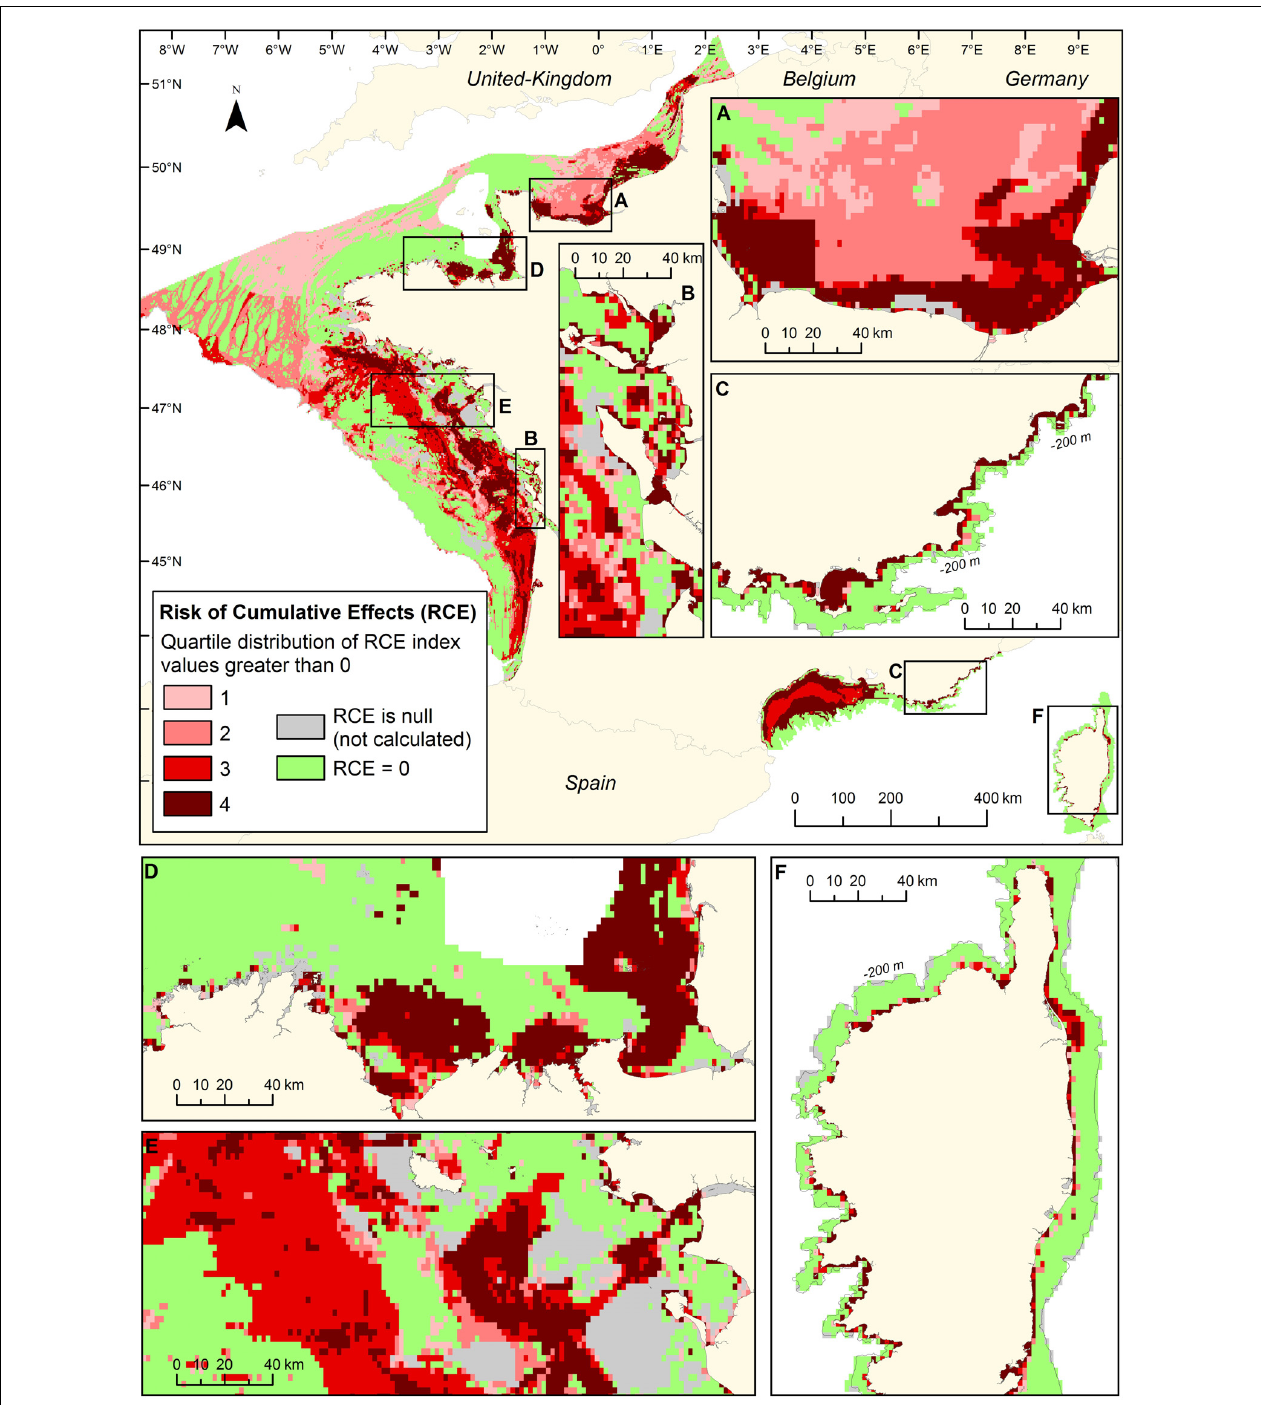
FIGURE 5 | Risk of Cumulative Effects map. (A) Bay of Seine, (B) Pertuis Charentais and Gironde estuary, (C) French Riviera (Côte d’Azur), (D) Normand-Breton Gulf, (E) Loire estuary, (F) Corsica.